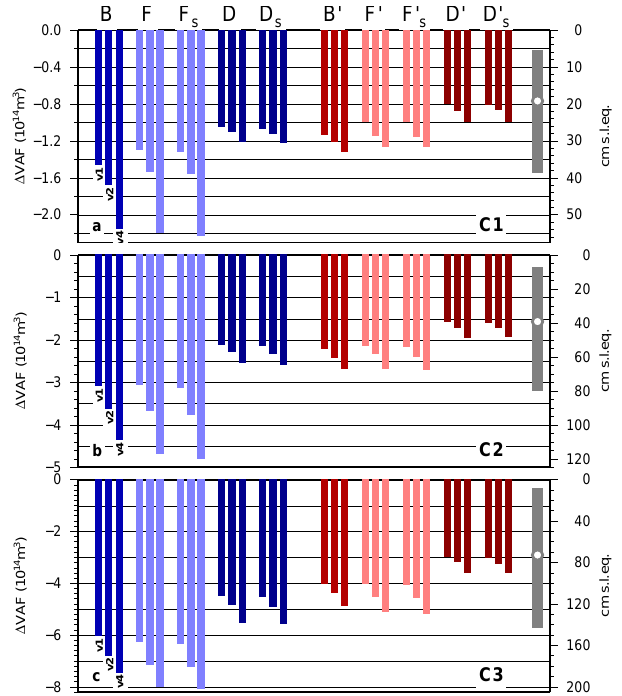
Figure 4. The same figures as Fig. 2 under experimental configu- ration of B , F , F s , D , D s , B (cid:48) , F (cid:48) , F (cid:48) s , D (cid:48) , D (cid:48) s . The left five experi- ments apply Tarasov and Peltier (2002) while the right five apply Huybrechts and de Wolde (1999) for the surface mass balance com-